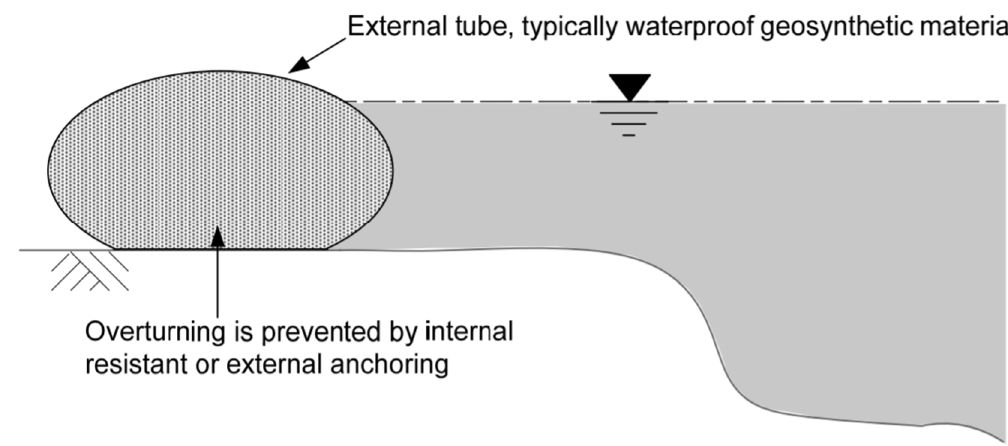
Figure A1. Air- or water-filled tubes, derived from Ogunyoye et al. [15].